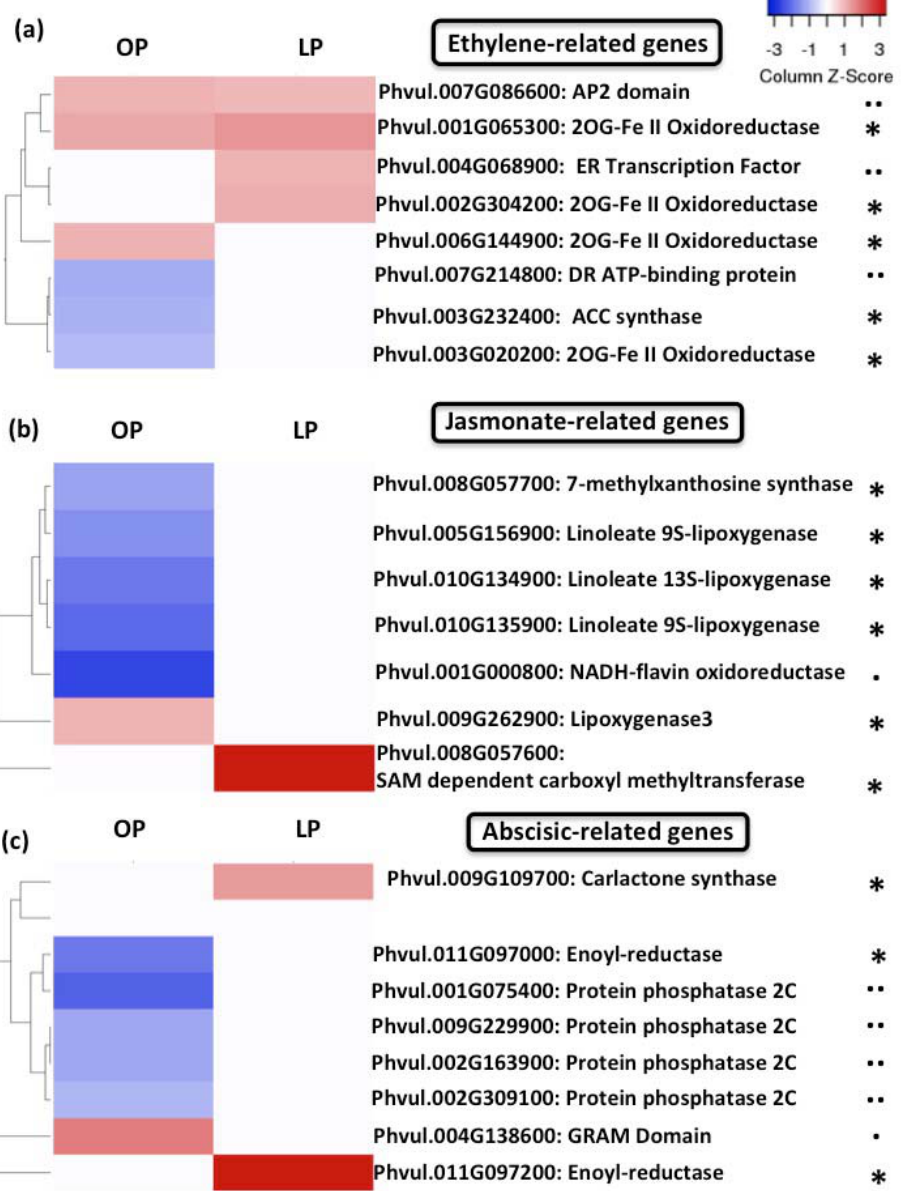
Figure 8. Pi deficiency induce the expression of ethylene-, jasmonate-, and abscisic acid-related genes. Heat-map showing the fold-change of genes involved in the biosynthesis (*), homeostasis (#), signal transduction (..) of ethylene ( a ), jasmonate ( b ) or abscisic acid ( c ) in common bean seedlings growing under OP or LP conditions and inoculated for 48 h with rhizobia. Genes regulated by ethylene, jasmonate or abscisic acid are indicated with (.). Fold-changes were false-colored. Genes showing higher expression are shown in different scales of red color, whereas genes showing lower expression were colored in blue color.